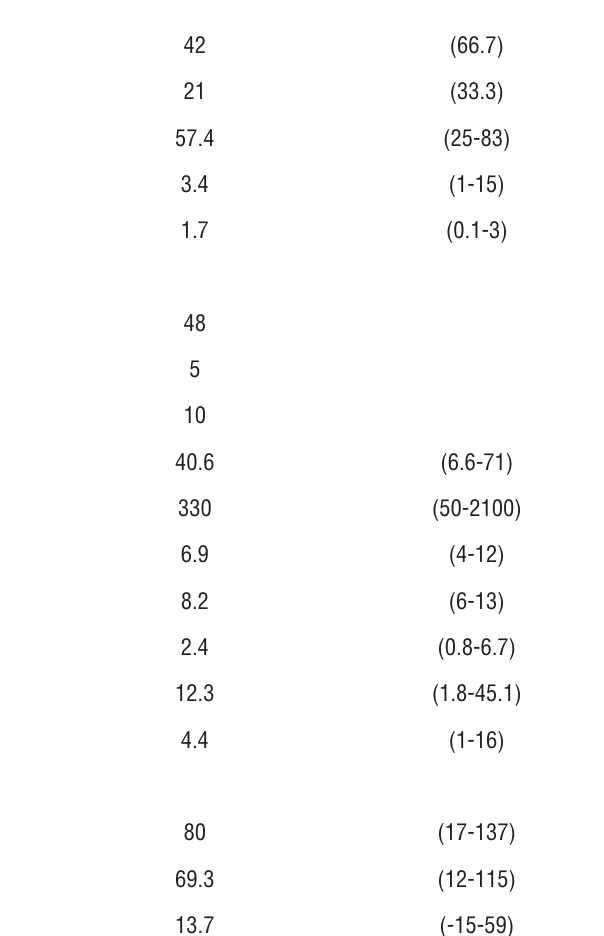
Table 1 - Demographic and perioperative data of 63 patients.